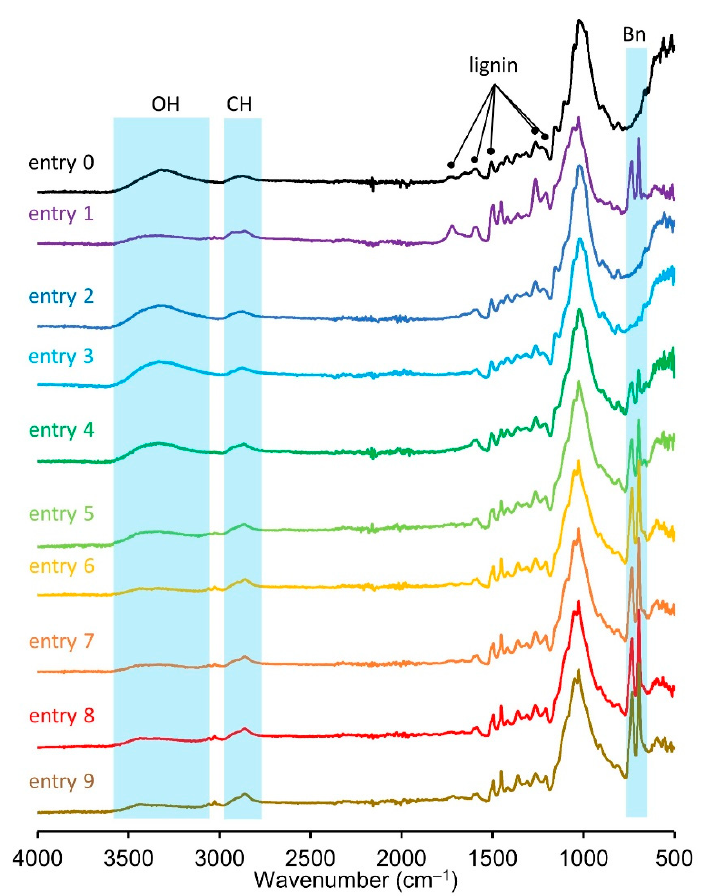
Figure 3. ATR-IR spectra of degreased wood (entry 0, black) and benzylated woods (entry 1, purple; entry 2, blue; entry 3, light blue; entry 4, green; entry 5, light green; entry 6, yellow; entry 7, orange; entry 8, red; and entry 9, brown).